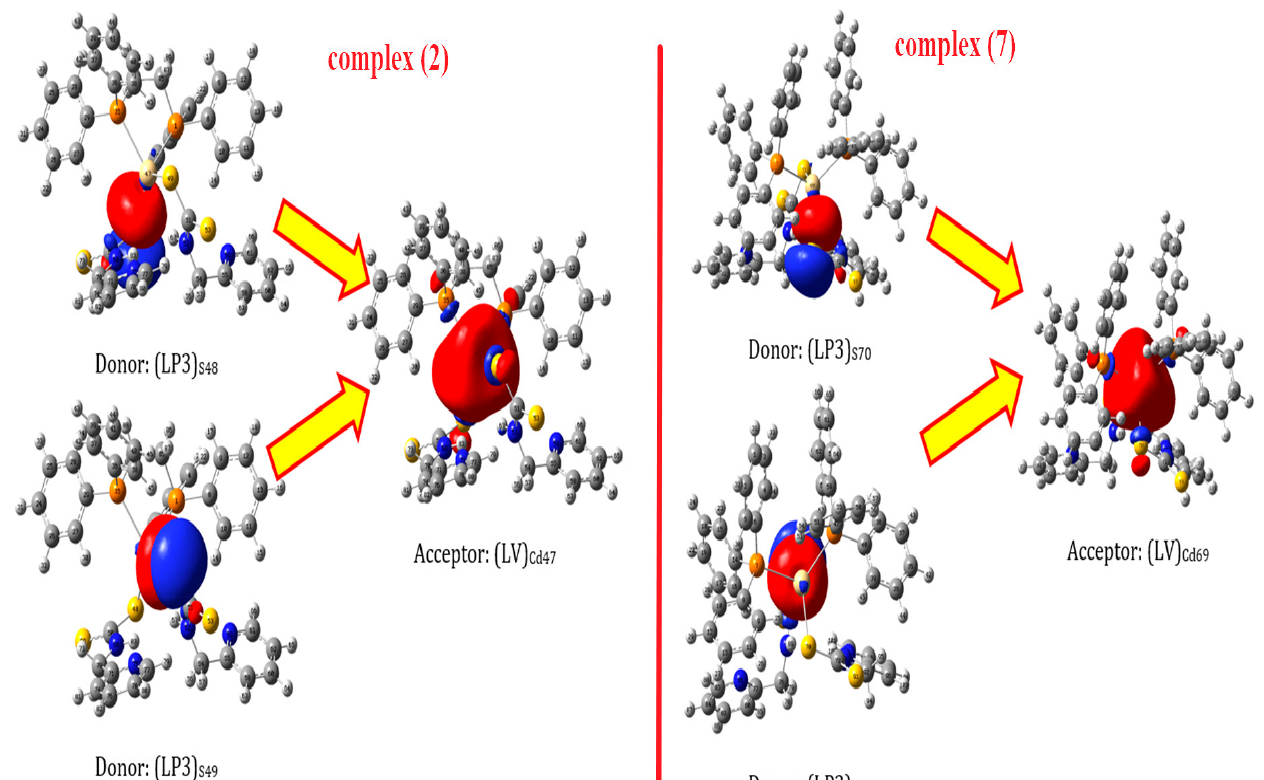
Figure 6. Two highest E (2) donors and acceptor orbitals for Cd(2) and Cd(7) complexes.